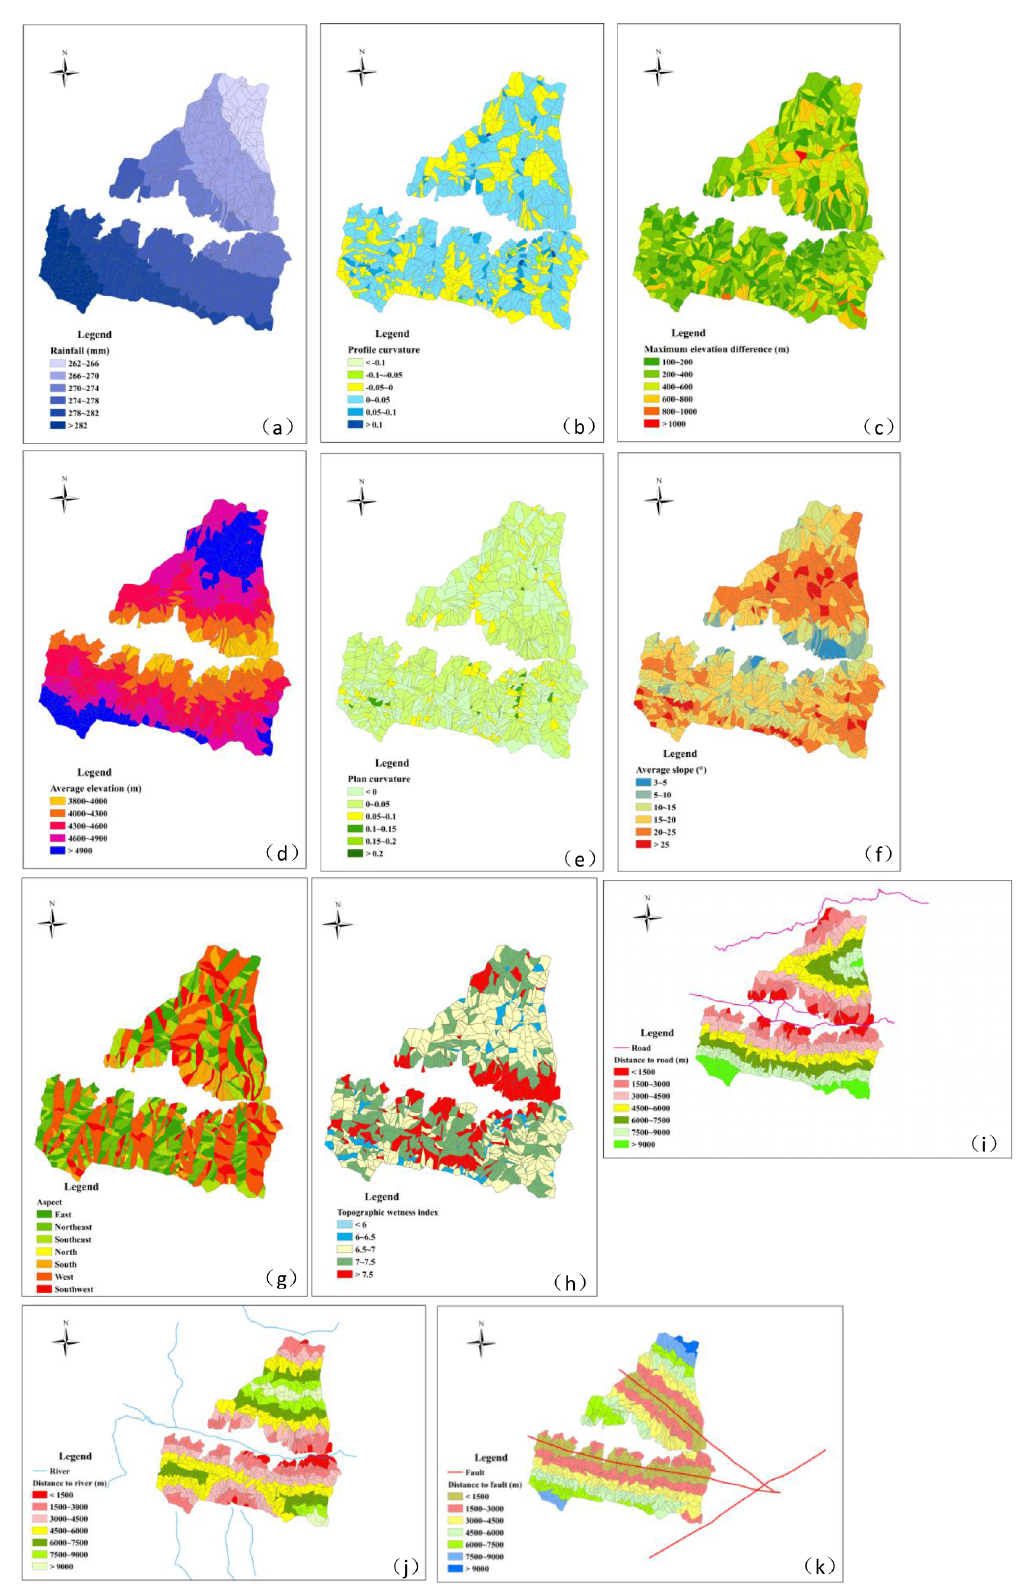
Figure 5. Study area thematic maps for landslide: (a) rainfall, (b) profile curvature, (c) maximum elevation difference, (d) average elevation, (e) plan curvature, (f) average slope, (g) aspect, (h) wetness, (i) distance to road, (j) distance to river and (k) distance to